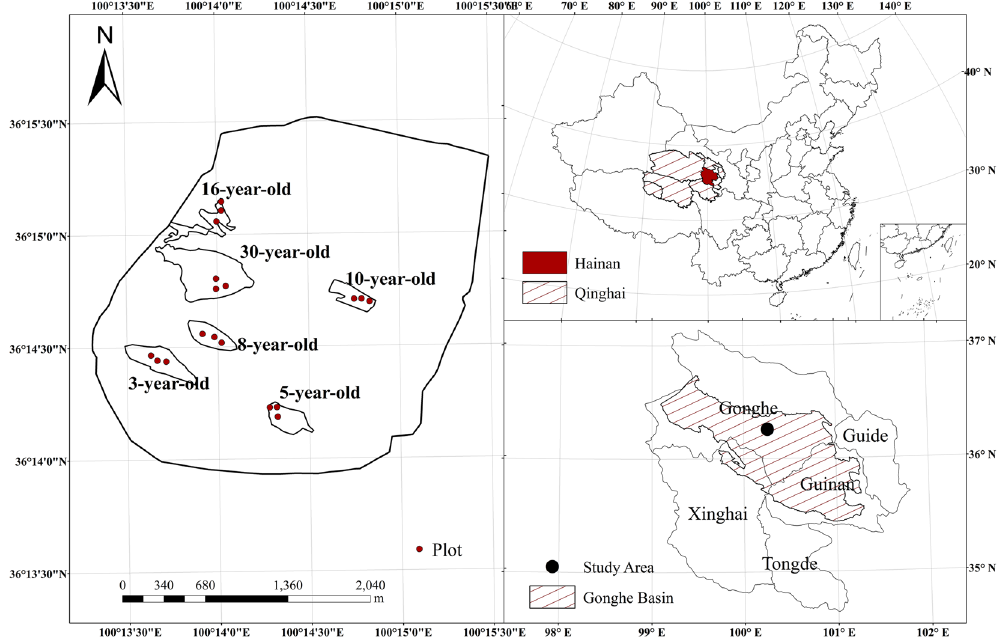
Figure 3. The sampling location of C. intermedia plantations in the Gonghe Basin, Qinghai Province,